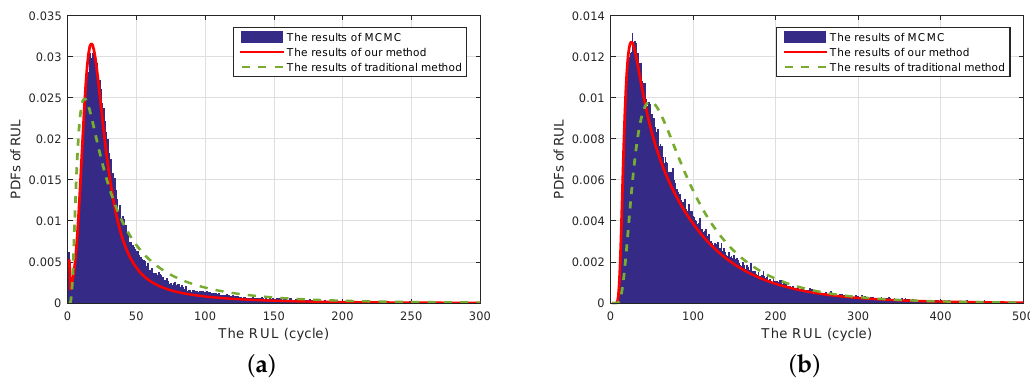
Figure 6. The comparison of PDFs of the estimated RUL at two different cycle. ( a ) The PDFs of RUL at cycle 568; ( b ) The PDFs of RUL at cycle